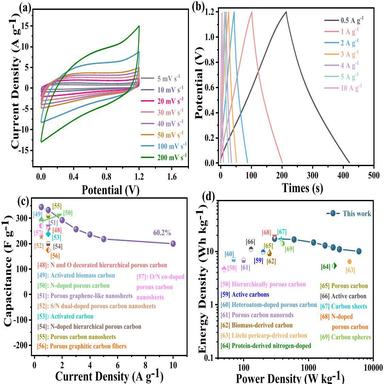
Electrochemical performance for NCTs-0.1–70 symmetric supercapacitor in 6 M KOH electrolyte in a two-electrode system. (a) CV curves, (b) GCD curves, (c) specific capacitance at different current densities from 0.5 to 10 A g−1 and comparison with other carbon materials, (d) Ragone plots for the NCTs-0.1–70 symmetric supercapacitor and other carbon materials symmetric supercapacitors reported in previously literature.